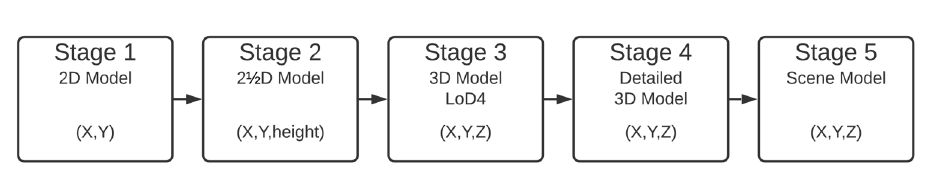
Fig. 1. The process of creating a 3D model for visualization in the game engine from